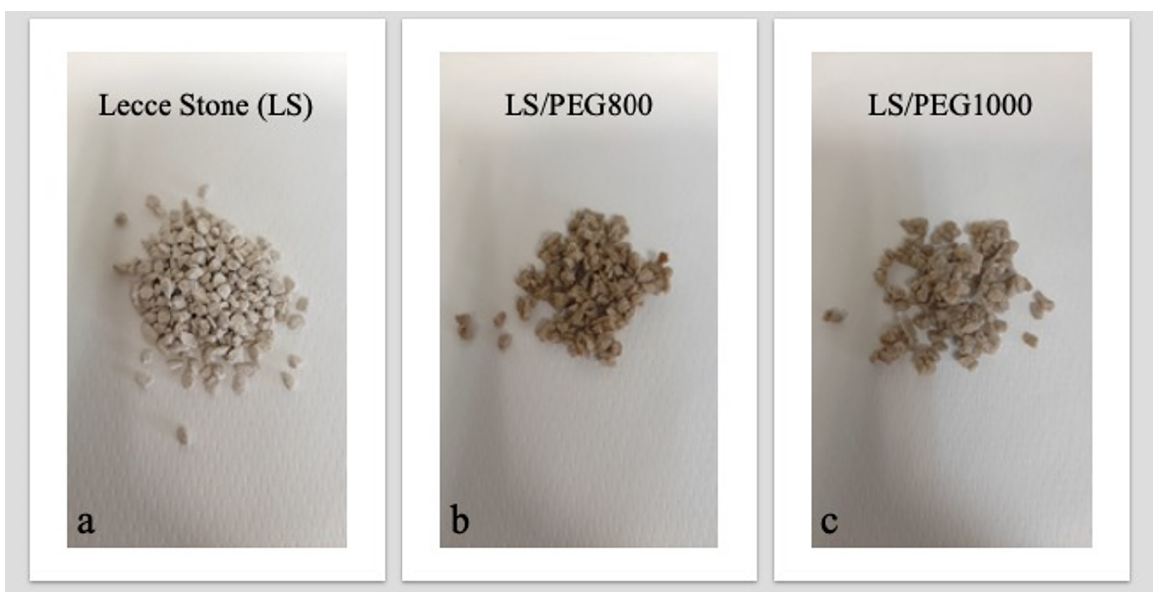
Figure 2. Aggregates used to produce the mortars: ( a ) granules of Lecce stone (LS) to manufacture the reference mortars; ( b ) granules of LS/PEG800 composite PCM; ( c ) granules of LS/PEG1000 composite PCM.